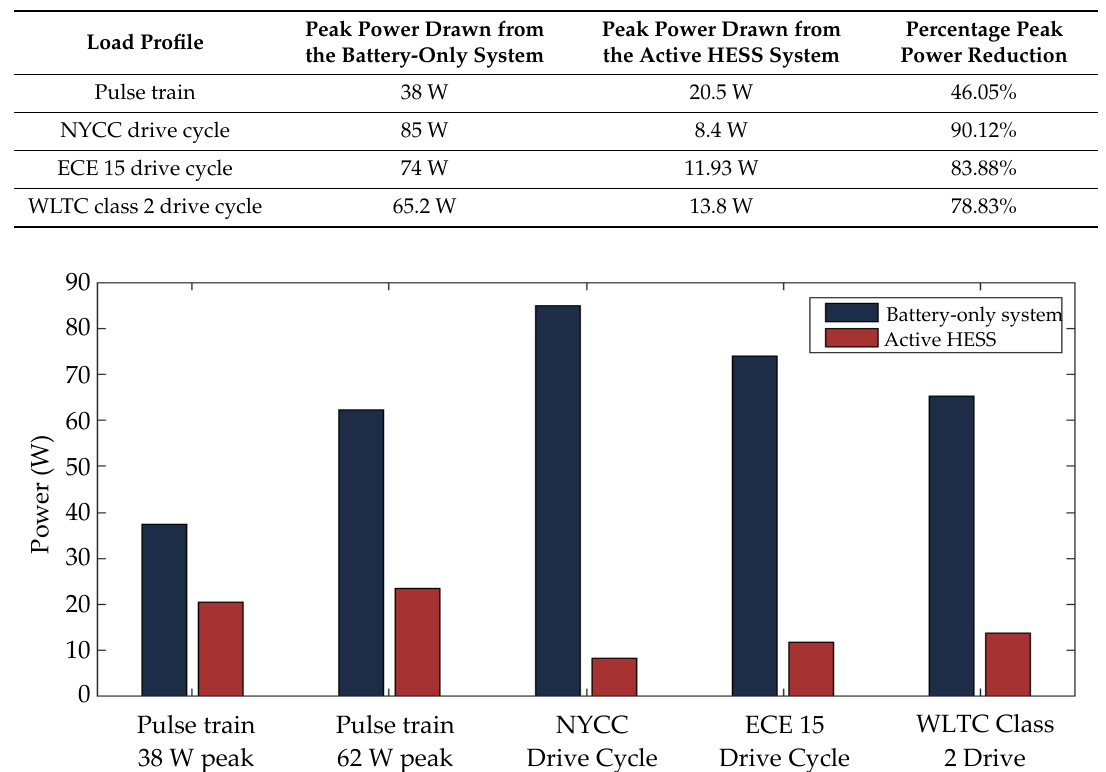
Figure 19. Comparison between peak power drawn from battery-only system and active HESS.